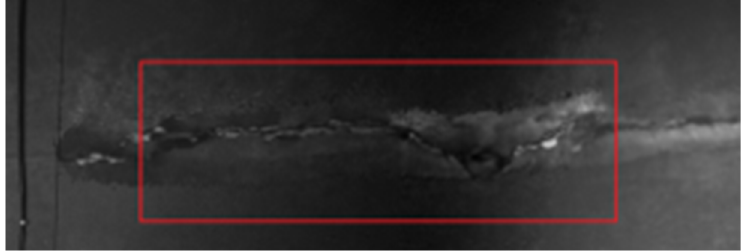
Figure 12. Structural defects are visible at the corresponding anomalous locations in the GPR profile.